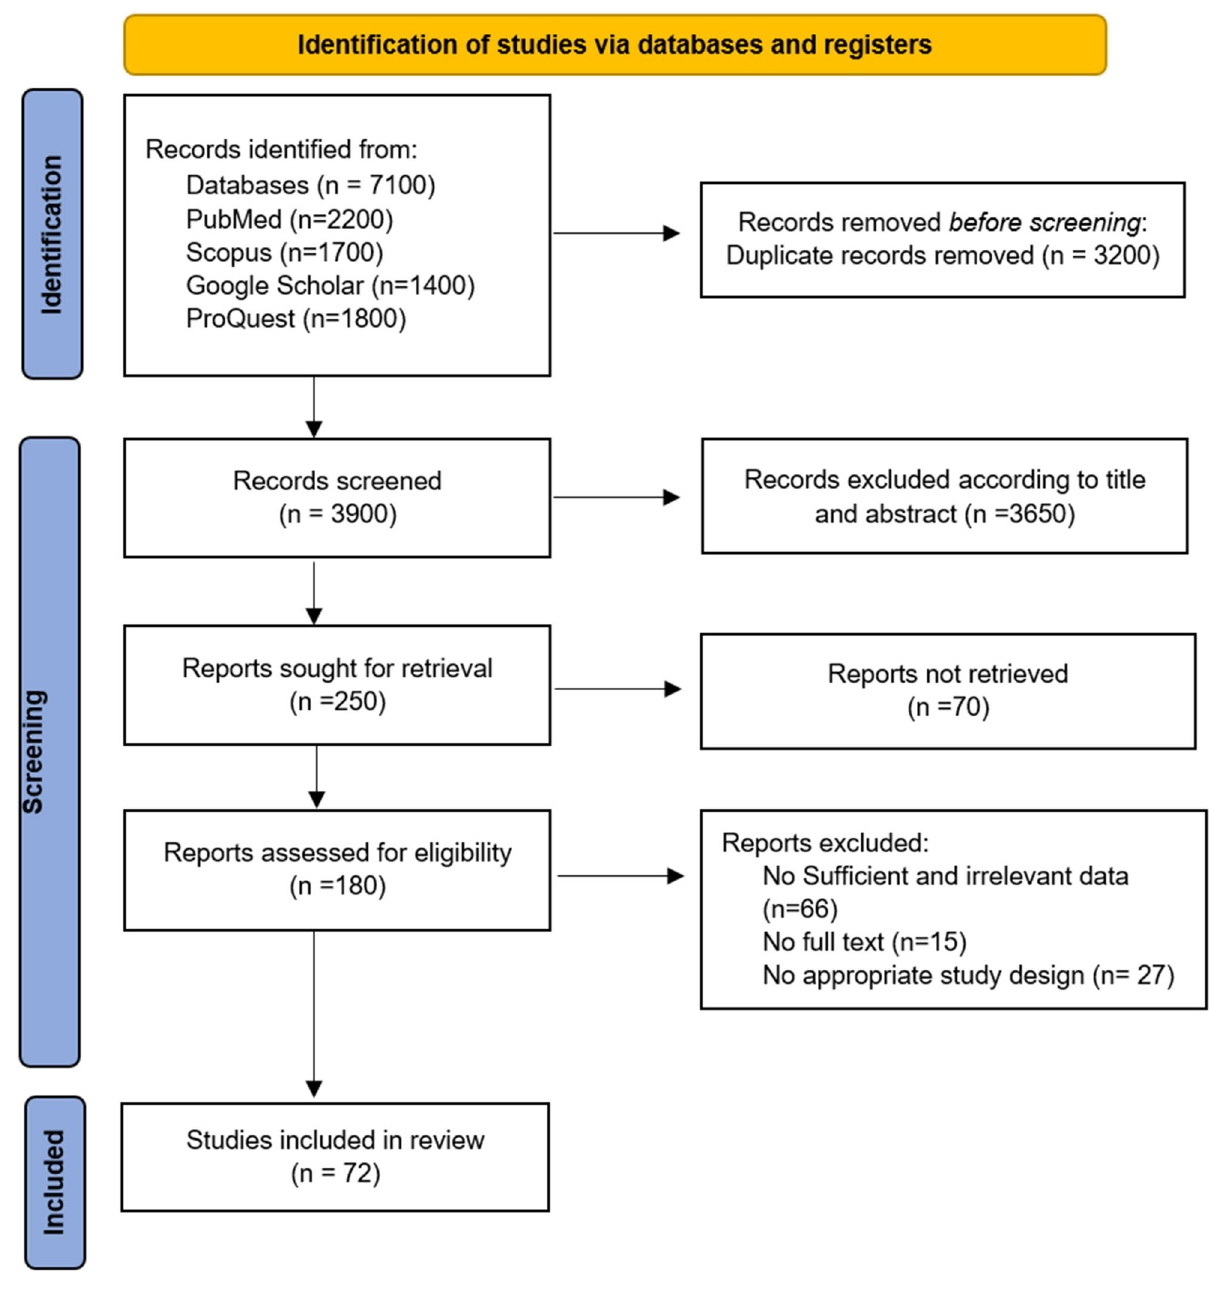
Figure 1. Preferred reporting items for systematic reviews and meta-analyses (PRISMA) flow chart for study selection